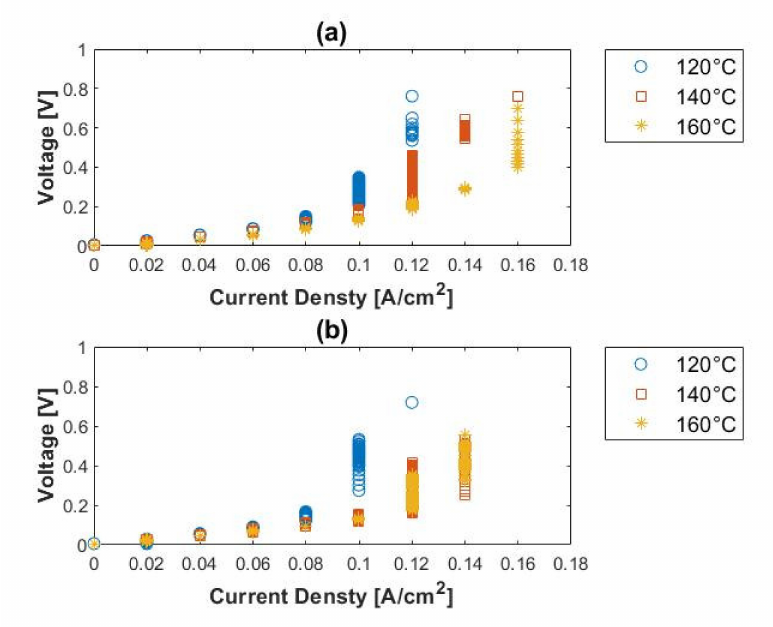
Figure 11. Polarization curves for ( a ) 10%, ( b ) 50% carbon dioxide, balance hydrogen (hydrogen flow rate = 100 mL n /min, 1